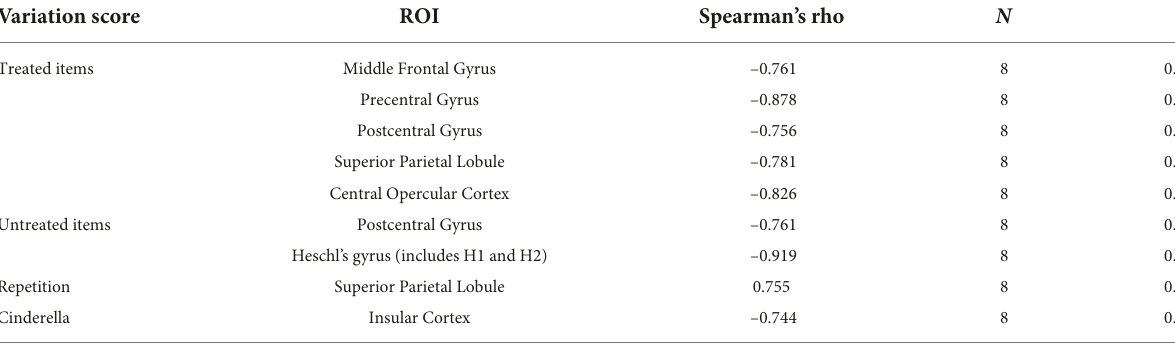
TABLE 7 Significant correlations between damaged voxels within ROI and variation scores.